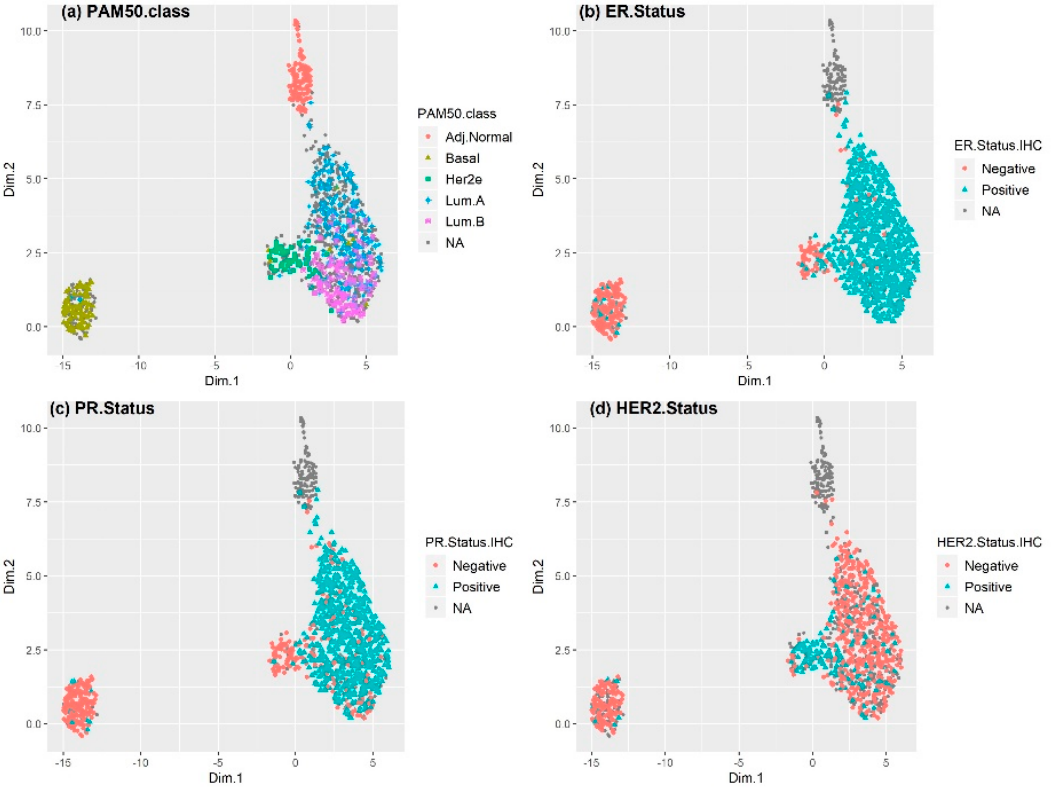
Figure 1. Uniform manifold approximation and projection (UMAP) plot showing the receptor status in the TCGA Breast Invasive Carcinoma (BRCA) cohort. Each point represents a sample; the color of the spots corresponds to the ( a ) subtype (PAM50 class), ( b ) ER status, ( c ) PR status, and ( d ) HER2 status of the sample. The tumor subtype, as well as the status of ER, PR, and HER2, were based on the available clinical data. Gray points are samples with no available clinical information. A small percentage of the luminal A and B subtypes were ER- / PR- and HER2 + . Such discordances were also observed in some breast cancer patients with the HER2-enriched and basal-like subtypes. Although most HER2 + and HER2-enriched subtype samples overlapped, some HER2-enriched subtype samples were found to be HER2-breast cancer and to exhibit basal-like subtype features. Some samples were ER + and / or PR + , representing a luminal subtype.